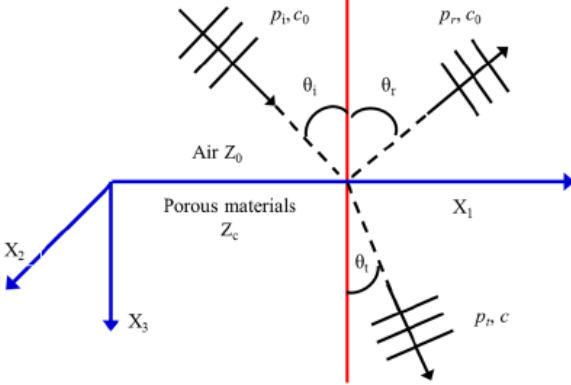
Figure 10. The reflection and refraction diagram of plane waves propagating at interface between the air and the porous material.